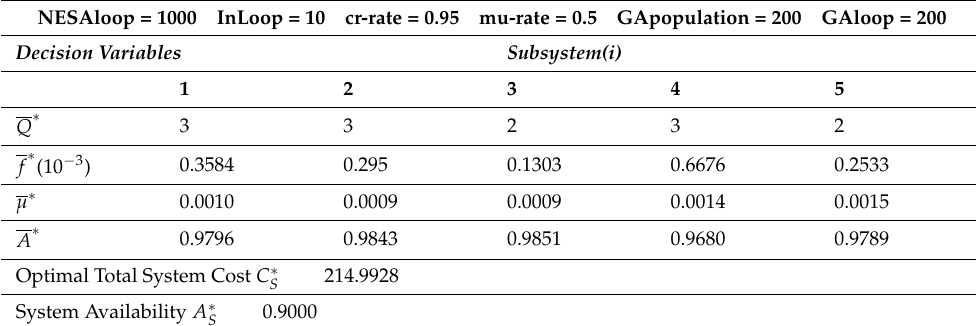
Table 23. The total system costs of 20 simulation runs obtained by MRAH–MGA for the parallel- series system. cr-rate = 0.95 mu-rate = 0.5